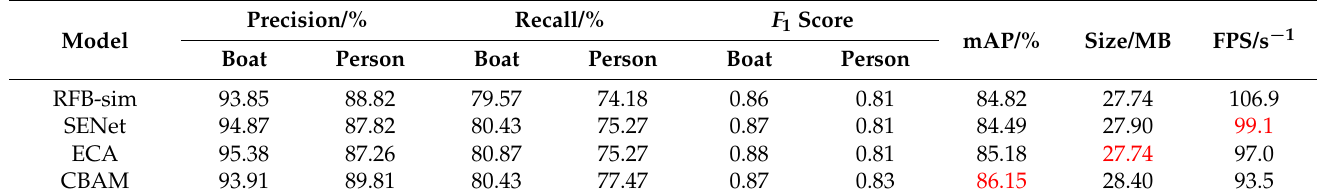
Table 3. Experimental results of adopting RFB_sim and various attention mechanisms. The first row indicates the experimental data with the introduction of the RFB_sim module, and the rest indicate the results of different attention mechanisms based on the introduction of RFB_sim.